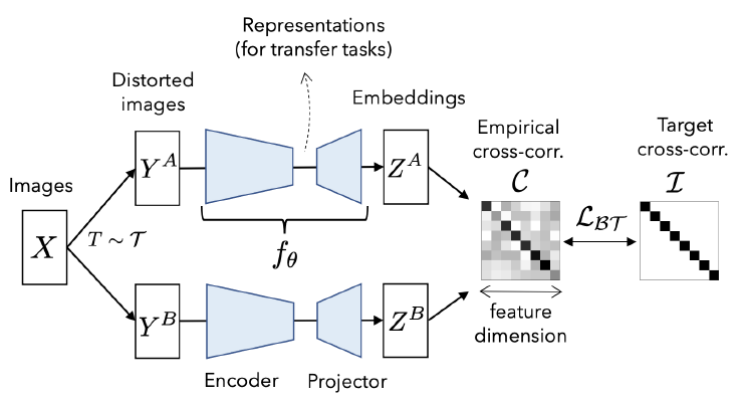
Figure 19. Barlow’s Twins Architecture (https://sh-tsang.medium.com/review-barlow-twins-self- supervised-learning-via-redundancy-reduction-967769fafc1), accessed on 15 September